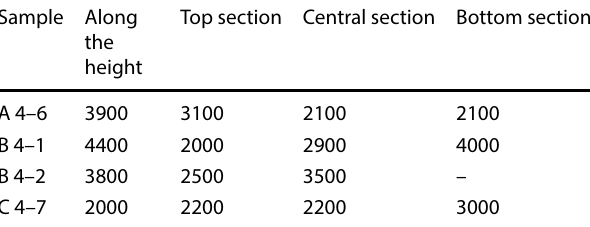
Table 2 UPV measured for the concrete slab samples (m/s) on the top, central and on the bottom of the section analysed for each samples